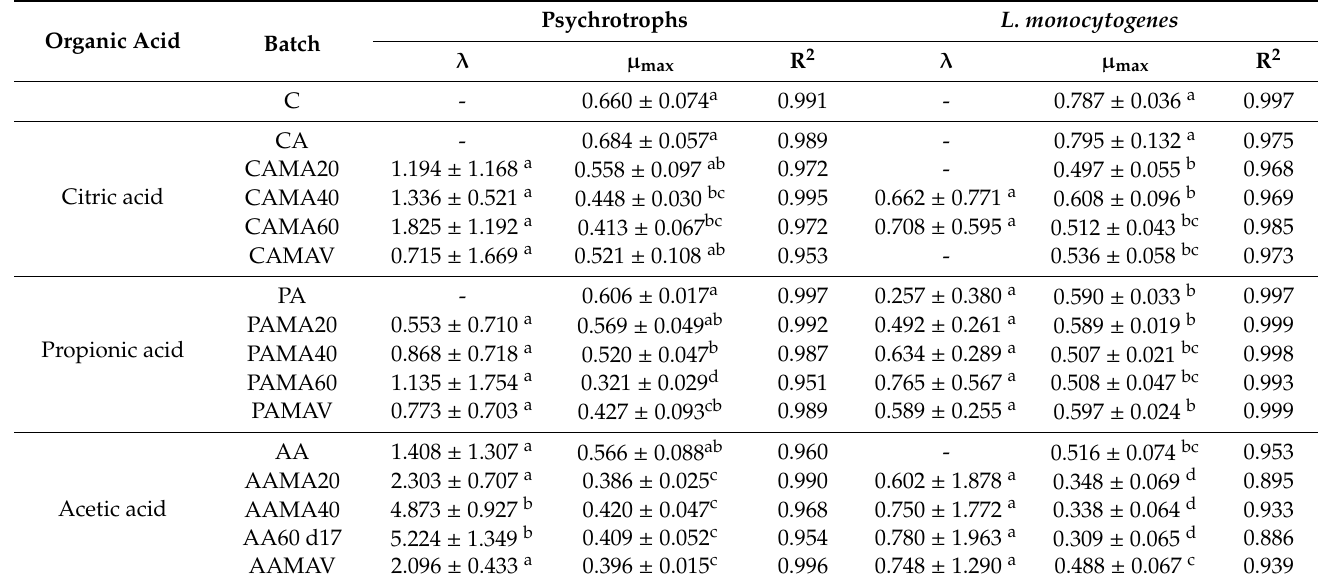
Table 3. Growth parameters of psychrotrophs and L. monocytogenes in chicken immersed in di ff erent organic acids (citric, propionic and acetic acids) and packaged under modified